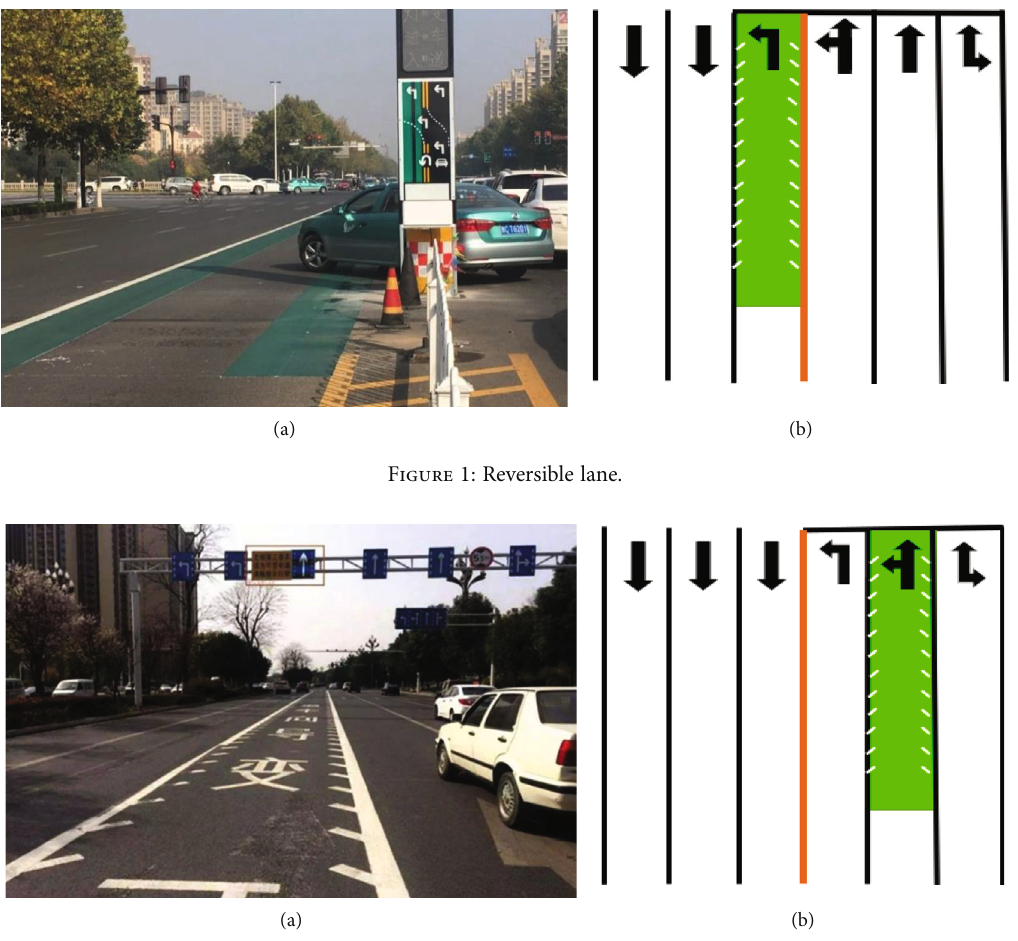
Figure 2: Variable guidance